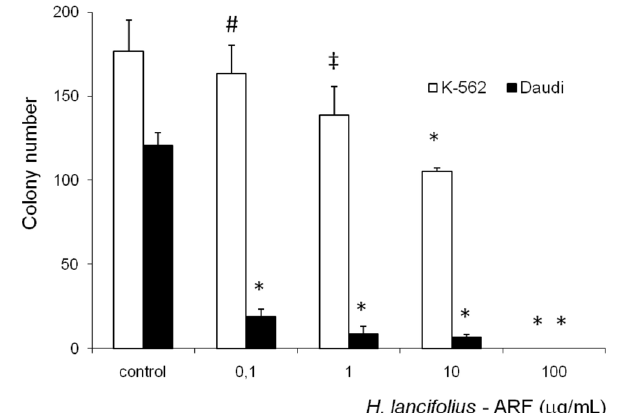
FIGURE 4 - Inhibition of the clonogenic potential of leukemic cells by H. lancifolius alkaloid-rich fraction. Exponentially growing K-562 (10 3 /mL) and Daudi cells (10 4 /mL) were continuously exposed to increasing doses of ARF of H. lancifolius in soft-growing systems for 7 days at 37 °C and 5% CO , as described in Materials and Methods. Each bar represents 2 the mean ± EPM of colonies formed, scored under an inverted microscope. [#] p =0.025; [‡] p <0.05; [*] p